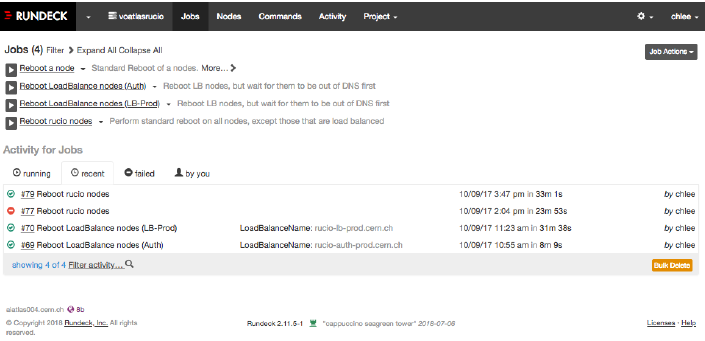
Figure 2. RunDeck server showing successes and failures of